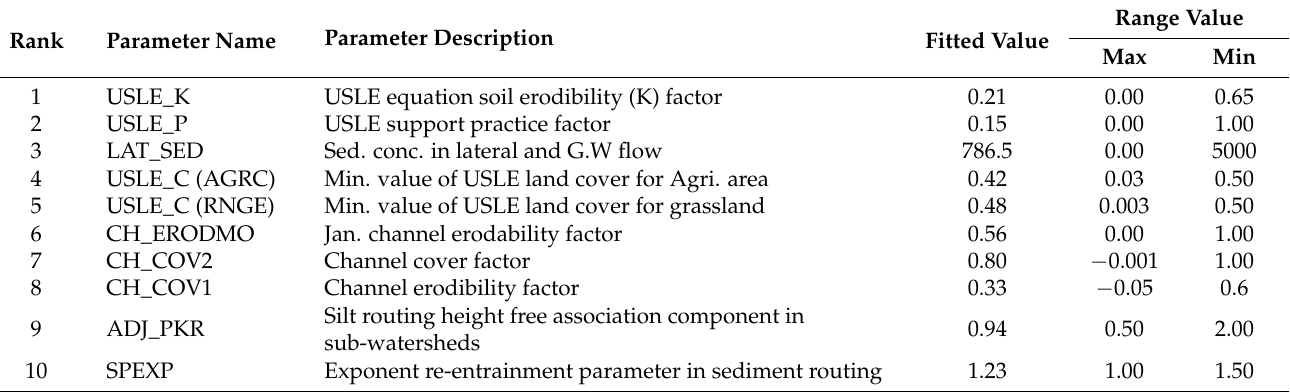
Table 4. List of parameters sensitive to siltation and their acceptable